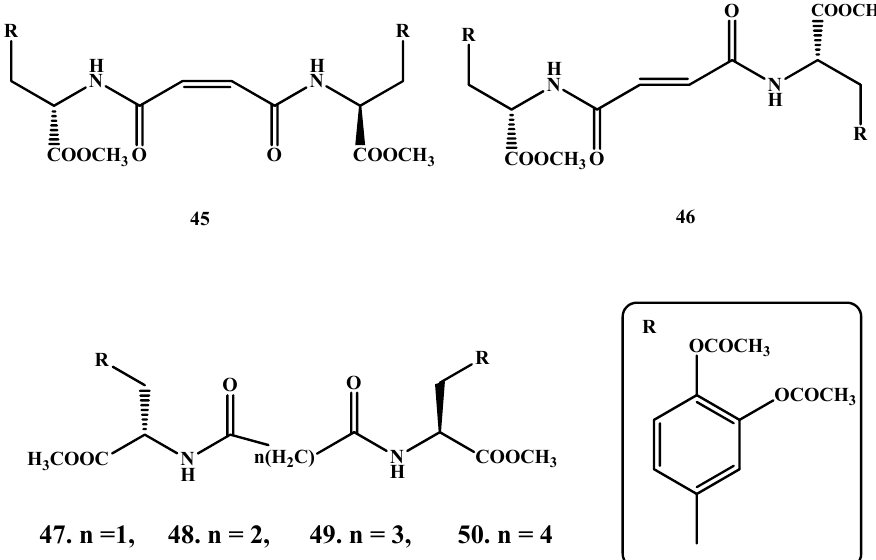
Figure 7. Chemical structures of dimeric amide prodrugs , 42 – 50 .